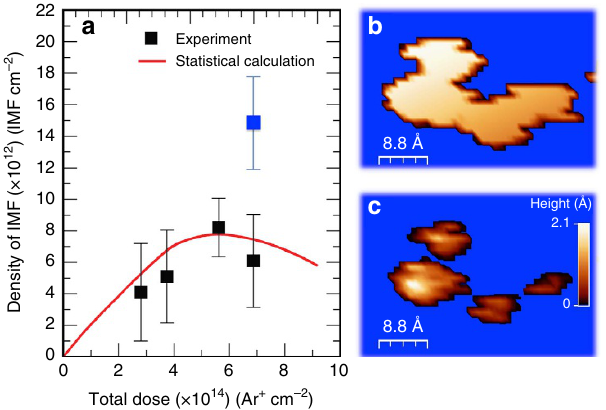
Figure 4 | Evolution of the covalently linked vacancies with the ion dose. ( a ) Density of isolated molecular features (IMF), in (cid:3) 10 12 IMF cm (cid:2) 2 units, versus total dose of Ar þ ions, in (cid:3) 10 14 Ar þ cm (cid:2) 2 units: (black-solid squares) statistical counting extracted from a large amount of experimental STM sessions for different Ar þ irradiation time; (red-solid line) Akima- spline fitting of the statistical predictions extracted from a calculation based on the generation of random circle-shaped events of radius 1nm within a (100 (cid:3) 100) nm 2 grid by differentiating isolated from overlapped events ( b ) STM image of several features that have coalesced into an unique one and are indiscernible and ( c ) Same image as ( b ) changing the saturation to see different maxima: the bump is formed by coalesce of four smaller protrusions. If the radius of 1nm is not taken into consideration the blue point is obtained after counting IMFs. STM image obtained using a bias of (cid:2) 798.7mV and tunnel current of 0.084nA. The magnitude of the error bars has been taken as the difference between the maximum and minimum values extracted from our phenomenological statistics, for the same STM scanning area, centered at the corresponding average values.